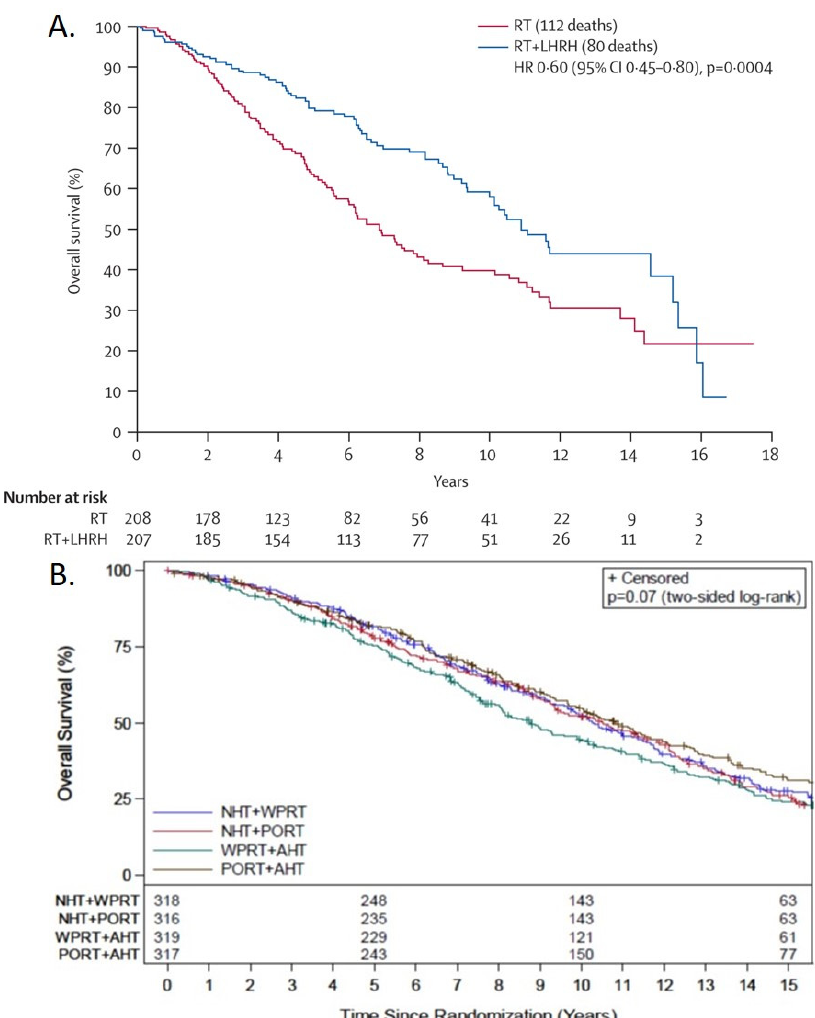
Figure 4. Overall survival in prostate cancer patients with locally advanced disease treated within the ( A ) EORTC trial 22863, which randomized patients to radiotherapy (RT) alone or to RT + luteinizing hormone-releasing hormone (LHRH) starting at day 1 of RT. Reprinted from The Lancet Oncology, Vol. number 11, Bolla, M.; Van Tienhoven, G.; Warde, P.; Dubois, J.B.; Mirimanoff, R.-O.; Storme, G.; Bernier, J.; Kuten, A.; Sternberg, C.; Billiet, I. External irradiation with or without long-term androgen suppression for prostate cancer with high metastatic risk: 10-year results of an EORTC randomised study. 1066–1073, 2010, with permission from Els1evier. ( B ) RTOG 9413 trial randomized patients to neoadjuvant hormonal therapy (NHT) or adjuvant hormonal therapy (AHT) with radiation to prostate only (PORT) or to the whole pelvis (WPRT). Reprinted from The Lancet Oncology, Vol. number 19, Roach, M.; Moughan, J.; Lawton, C.A.F.; Dicker, A.P.; Zeitzer, K.L.; Gore, E.M.; Kwok, Y.; Seider, M.J.; Hsu, I.C.; Hartford, A.C., et al. Sequence of hormonal therapy and radiotherapy